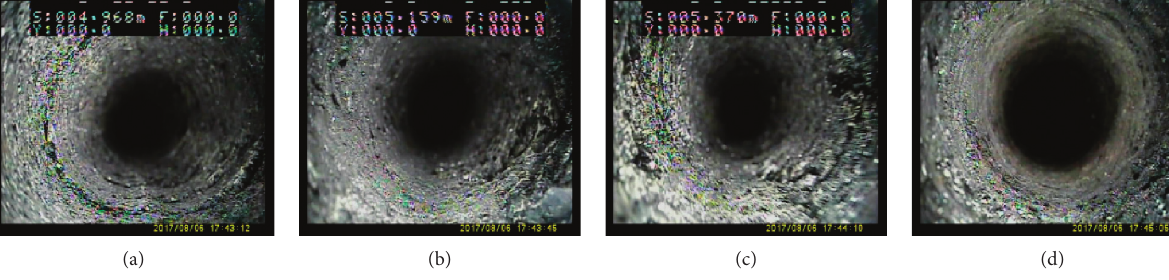
Figure 11: The distribution of the surrounding rock (2.5–3.8m) outside the anchor zone. (a) 2.5m. (b) 2.9m. (c) 3.4m. (d) 3.8